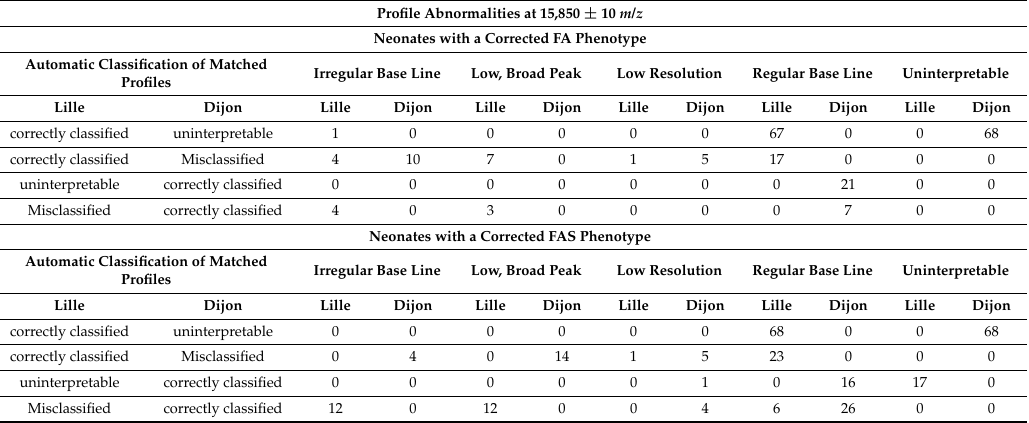
Table 5. Paired classification of the samples by the two analytical facilities. Relationship with the spectral quality. This table summarizes the number of profiles correctly classified, misclassified and uninterpretable for each category of profile quality and for the two analytical laboratories. ProfileAbnormalitiesat15,850 ± 10 m / z